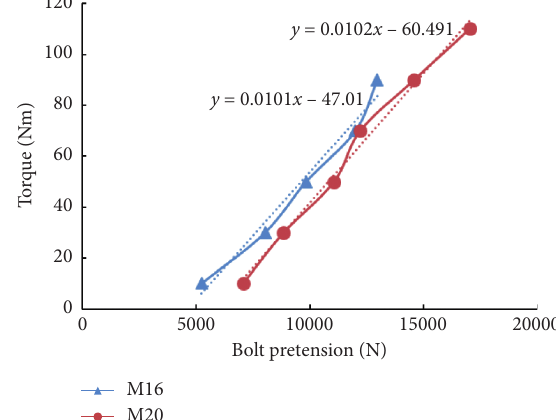
Figure 17: Torque-pretension curve according to the properties of disk springs.